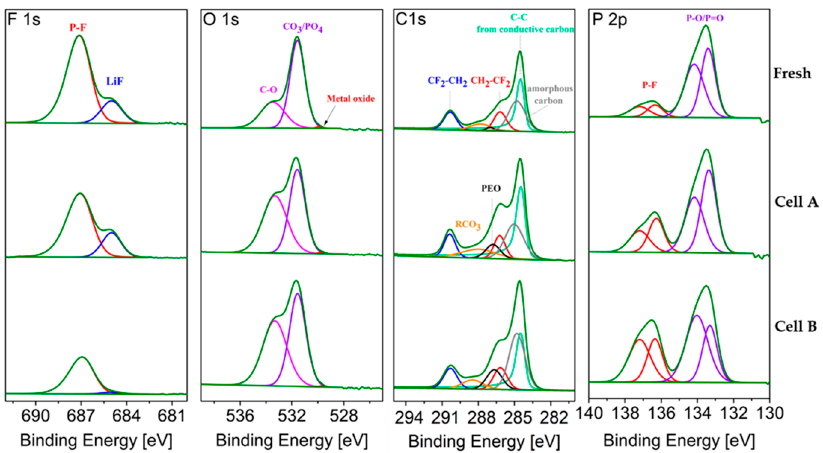
Figure 10. F 1s, O 1s, C 1s and P 2p core peaks XPS spectra of LiFePO4 electrode from fresh and aged cells (MC samples). Non-sputtered samples. Table 7. Average atomic percentages (% at.) determined from three measurement spots on fresh and aged cathodes. Region